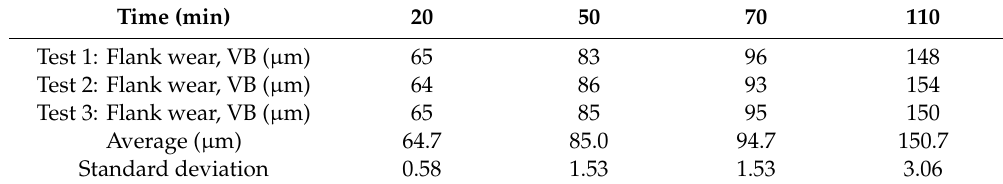
Table 5. Flank wear of Tool B.